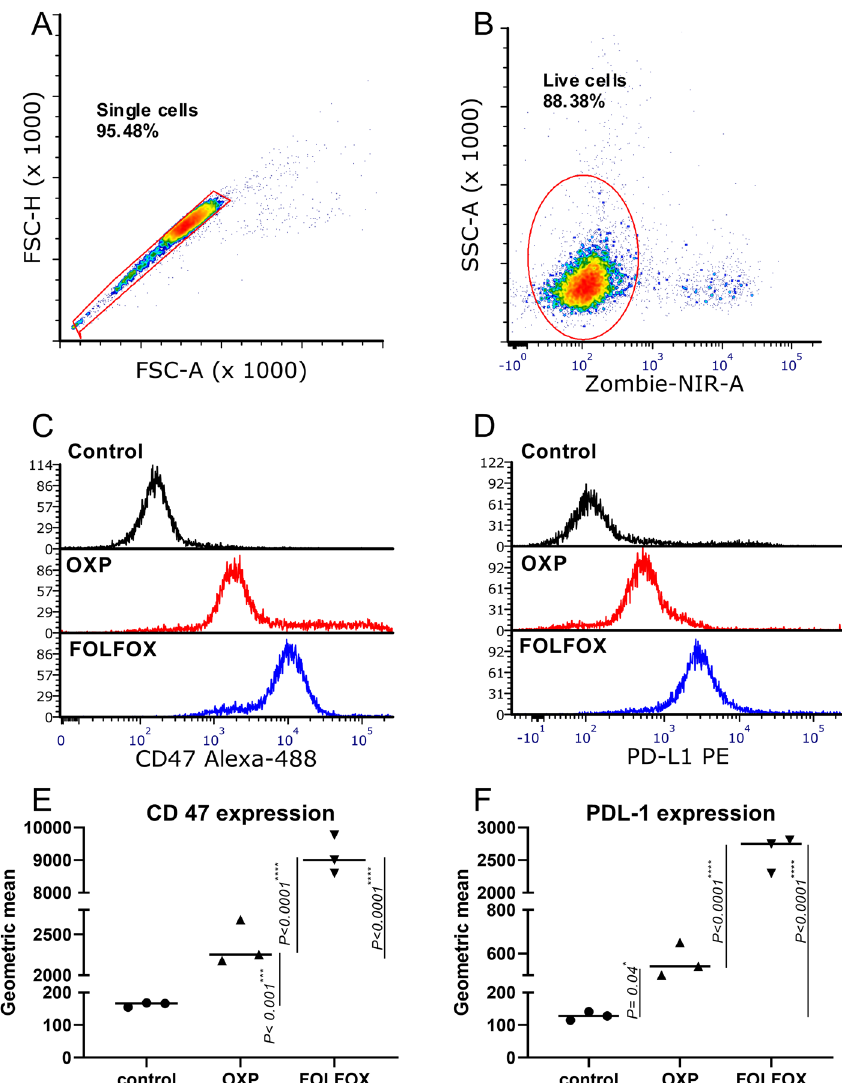
Figure 1. FOLFOX and OXP increased CD 47 and PD-L1 expression on the cell surface of CT-26 cell lines. ( A – D ) Gating strategies for analysis of CD47 and PD-L1 cell surface expression in CT-26 tumor cell line following treatment with OXP and FOLFOX. ( E ) CT-26 tumor cells were treated with OXP or FOLFOX, and CD47 expression was analyzed by flowcytometry. ( F ) tumor cells were treated with OXP or FOLFOX, and PD-L1 expression was analyzed by